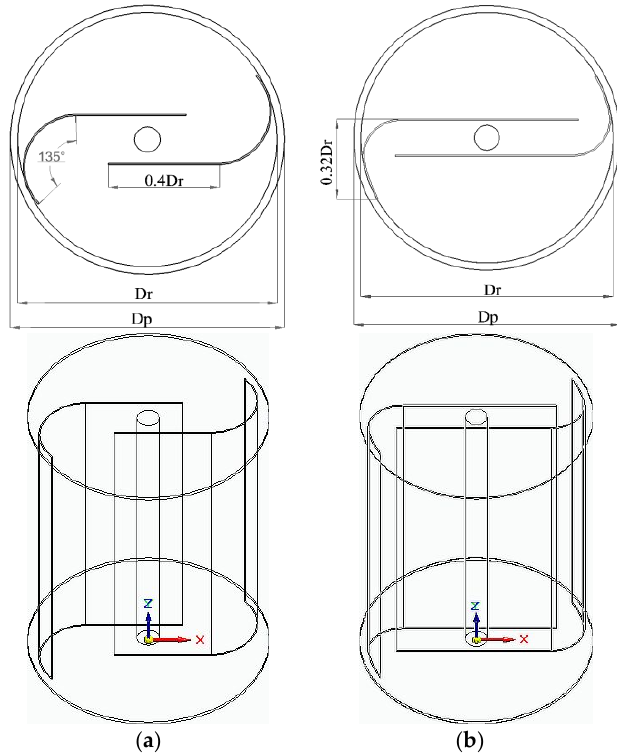
Figure 2. Schematically representation of Bach and Benesh rotor profile. ( a ) Bach-type rotor model [14]; ( b ) Benesh blade profile [17].. ( b ) Benesh blade profile